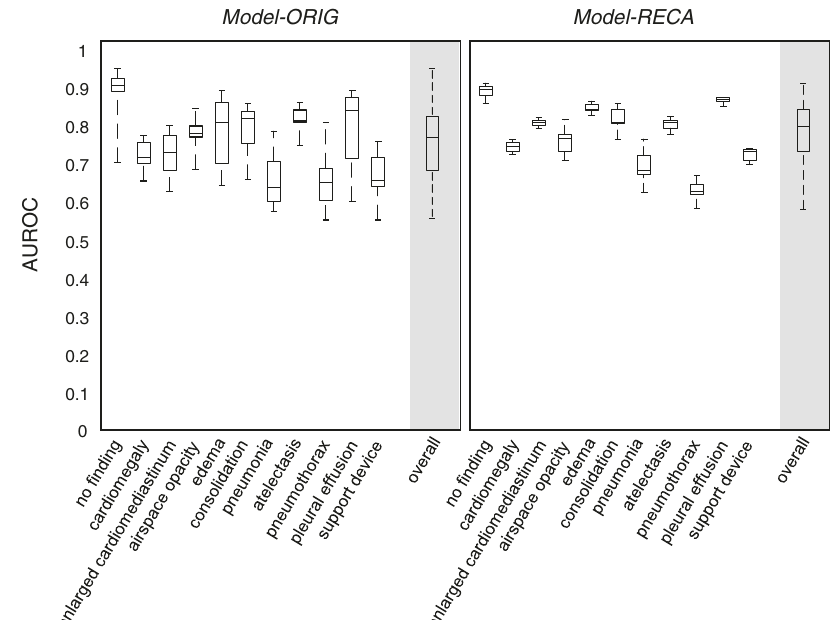
Fig. 4 Results of the device-variation experiment, in which the same set of 202 CheXpert CXRs were copied into photographs by ten different device settings. The box plots for the uncalibrated model ( Model-ORIG ) and recalibrated model ( Model-RECA ) show the median and interquartile range of AUROCs. In each box, the central line indicates the median, and the edges of the box indicate the 25th and 75th percentiles. Three labels “ fracture, ” “ lung disease, ” and “ pleural other ” were excluded in the plots because the numbers of cases are less than 1%. The intraclass correlation coef fi cient (ICC) score for the Model-ORIG is [0.39, 0.77] (95% con fi dence interval) and the ICC for the Model-RECA is [0.85, 0.93]. The p -value between these two ICCs is smaller than 0.0001, which indicates that Model-RECA provides more reliable radiographic detection